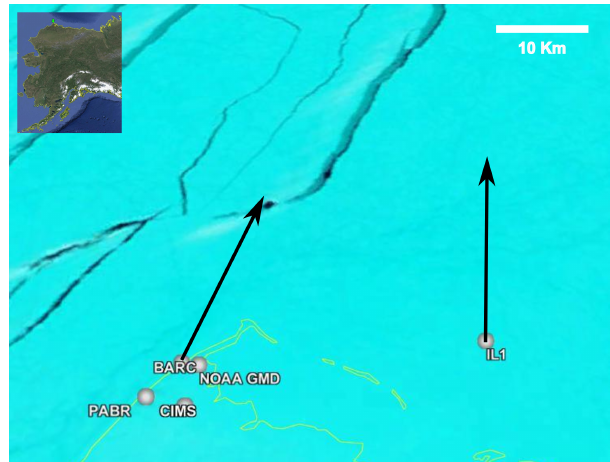
Figure 5. Field locations during the BROMEX field campaign over- lain on Moderate Resolution Imaging Spectrometer data from the Aqua satellite (bands 7, 2, and 1). This ice cover image is from 13 March 2012. These locations are Barrow Arctic Research Center (BARC), Chemical Ionization Mass Spectrometry (CIMS), NOAA Global Monitoring Division (NOAA GMD) station, IceLander 1 (IL1) buoy, and Barrow Airport (PABR), near to where most of Bar- row’s population resides. The distance between BARC and IL1 is about 36km. Viewing azimuths for each DOAS instrument are in- dicated with black arrows. The inset map of Alaska shows the study location marked in